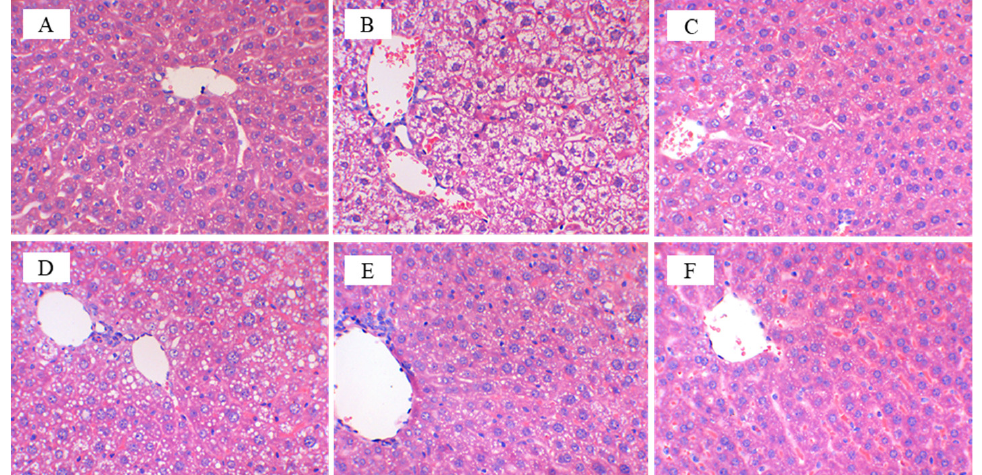
Figure 3. Effects of CFBT intervention on Hematoxylin-eosin staining of liver tissues. ( A ) Normal control group (CK); ( B ) High-fat model group (NK); ( C ) Positive control group (YK); ( D ) Low-dose CFBT (FL); ( E ) Medium-dose CFBT (FM); ( F ) High-dose CFBT (FH).